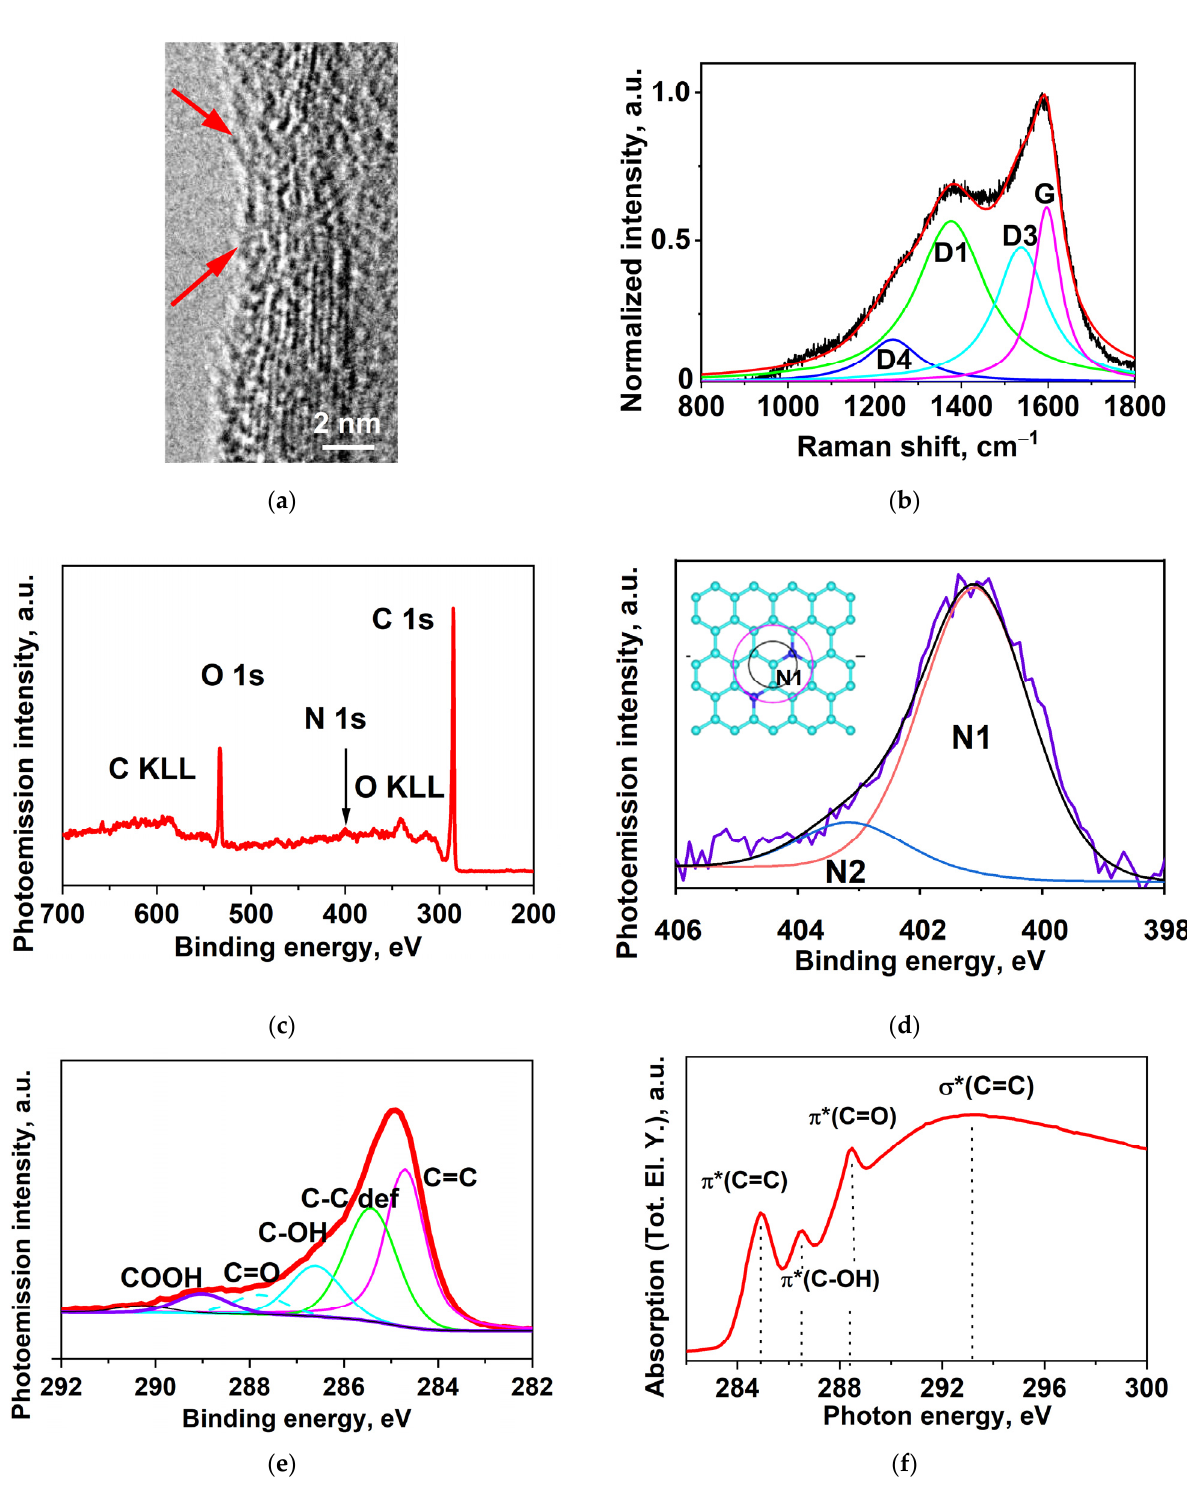
Figure 1. Experimental data on atomic and electronic structure of N-MWCNTs: ( a ) TEM, ( b ) nor- malized and baseline corrected Raman spectra, ( c ) survey, ( d ) core-level N1s, ( e ) C1s PE spectra of N-MWCNTs, and ( f ) their C1s NEXAFS spectrum.